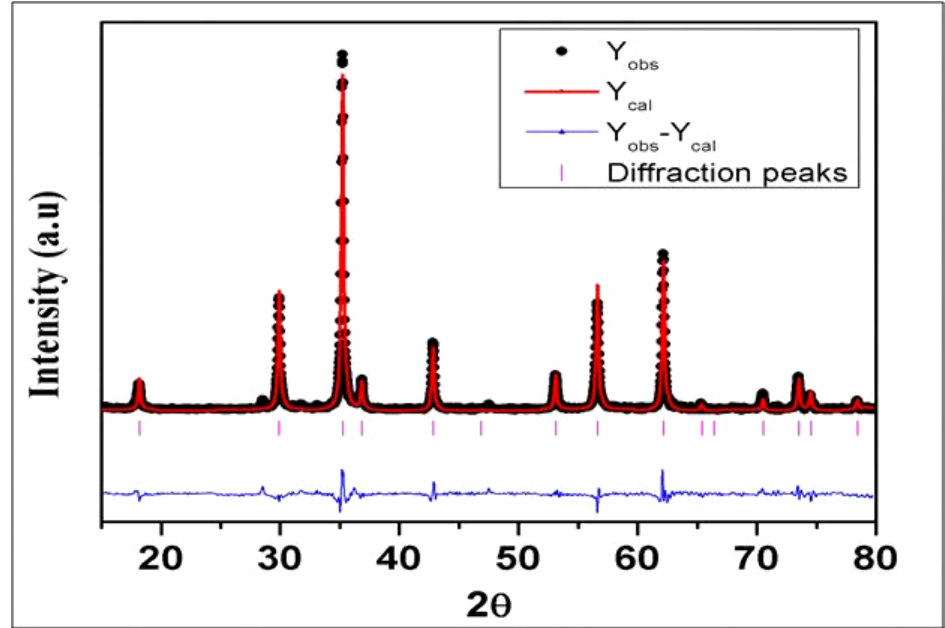
Figure 1. X-ray diffraction (XRD) pattern of ZnFe2O4 NPs.